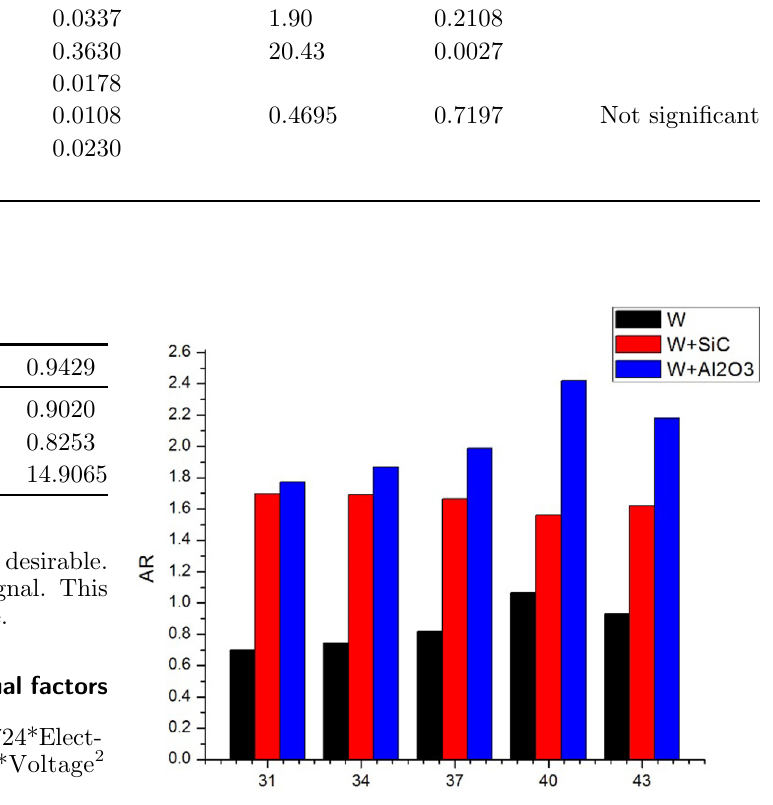
Fig. 7. Voltage vs. AR with different abrasives at 25% by Al 2 O 3 in